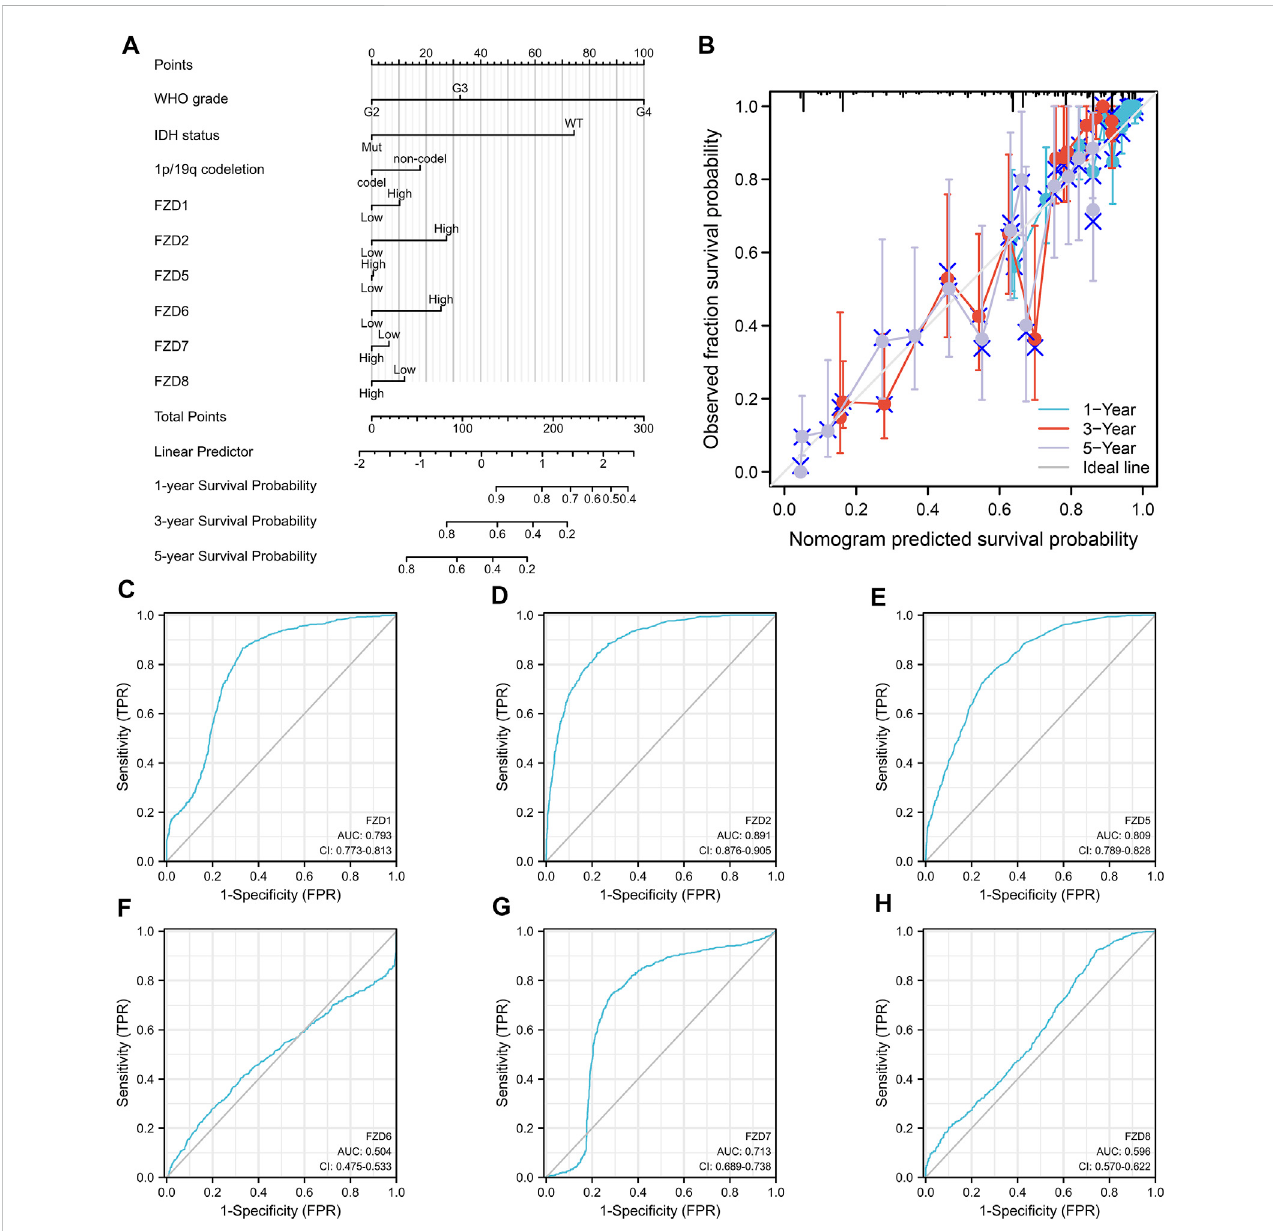
FIGURE 5 Diagnostic value of FZD1/2/5/6/7/8 in glioma. (A) Construction of the nomogram by integrating the expression of FZD1/2/5/6/7/8 with key clinical characteristics. (B) Calibrationcurveofthenomogramforpredictingtheoverallsurvivalat1,3,and5years. (C – H) DiagnosticvalueofFZD1,FZD2,andFZD5-8 mRNA